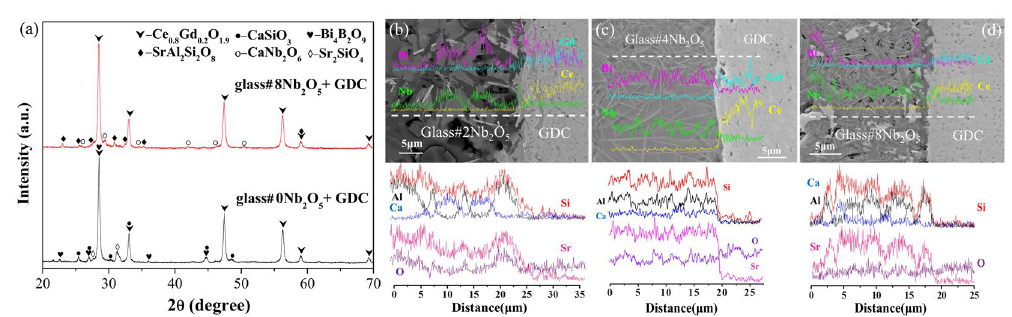
Figure 6. ( a ) XRD patterns of glass/GDC powder reaction couples held at 750 °C for 1000 h in air. Micrographs and elemental EDS line scans of the glass/GDC sealing couples held at 750 °C for 1000 h, for ( b ) glass#2 Nb 2 O 5 , ( c ) glass#4 Nb 2 O 5 and ( d ) glass#8 Nb 2 O 5